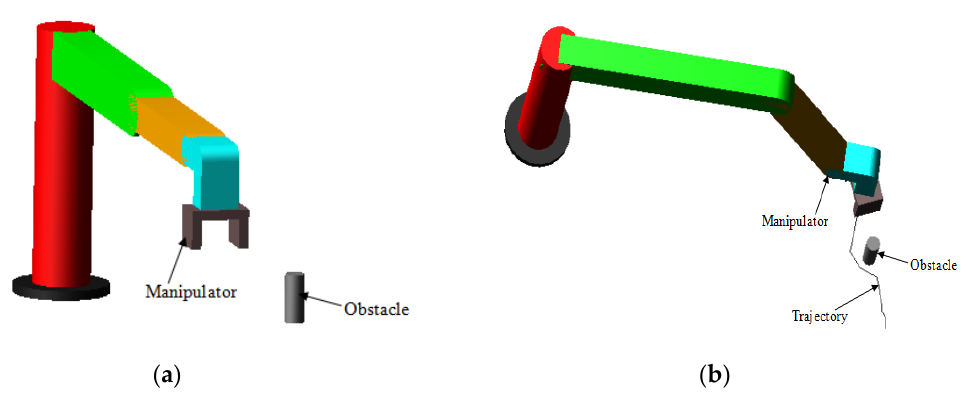
Figure 14. Movements state of the pickup manipulator in the obstacle environment. ( a ) Initial state of the pickup manipulator. ( b ) End state of the pickup manipulator.